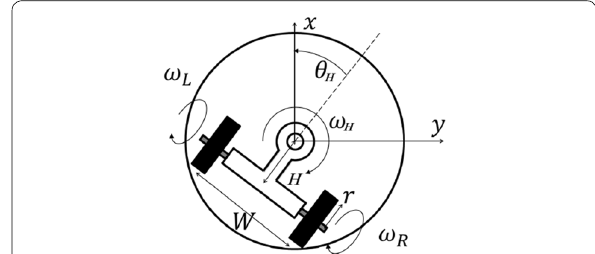
Fig. 16 Dual-wheel caster-drive mechanism [3]